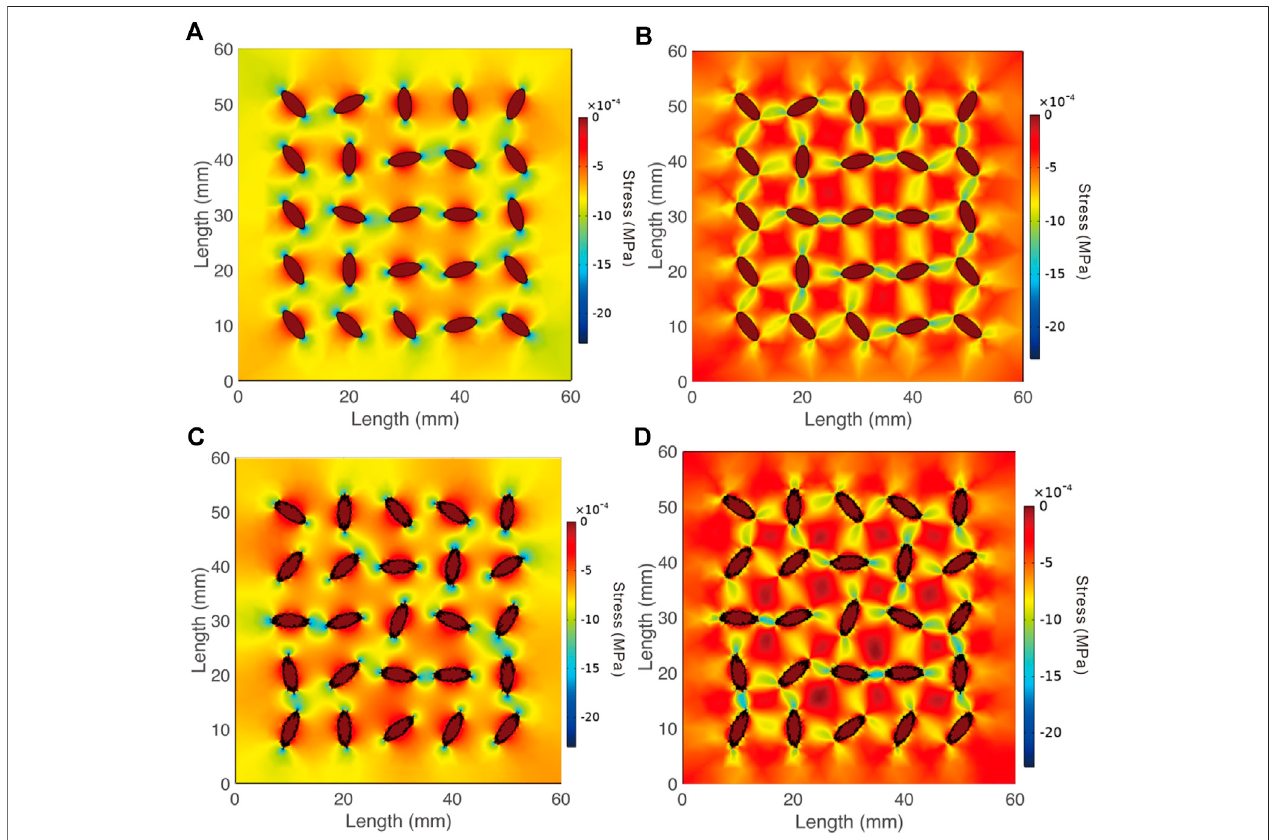
FIGURE9| Thestressdistributionofcrackedrockmodels, (A) normalstressdistributionofthecrackrockmodelwithdeviationas0, (B) shearstressdistributionof the crack rock model with deviation as0, (C) normal stressdistributionofthecrack rock model withdeviation as2.1 mm 2 , (D) shear stressdistribution ofthecrack rock model with deviation as 2.1 mm 2